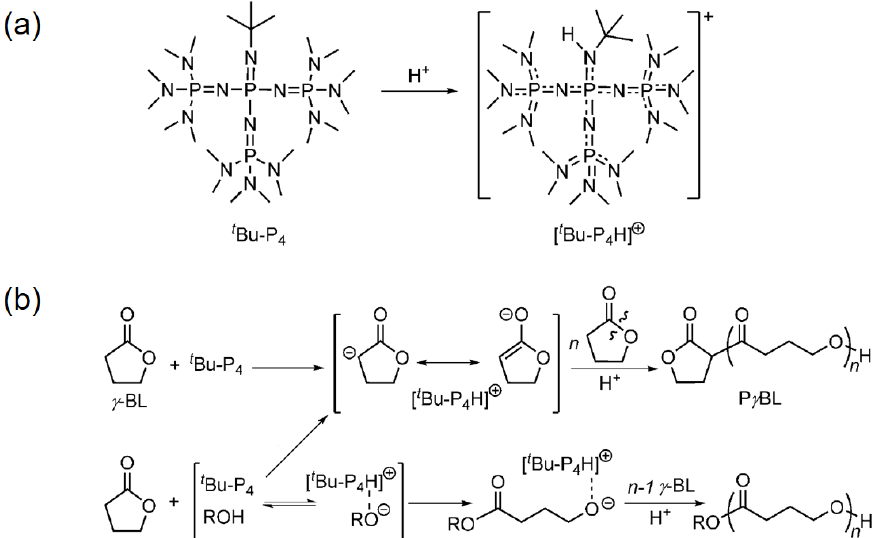
Figure 3. Reversible polymerization in ring-opening polymerization systems. ( a ) Structure and basicity of tert-Bu-P 4 ; ( b ) proposed mechanism for the tert-Bu-P 4 -catalyzed ROP of γ -BL (i) with and (ii) without alcohol as an initiator. Reproduced with permission from [71].